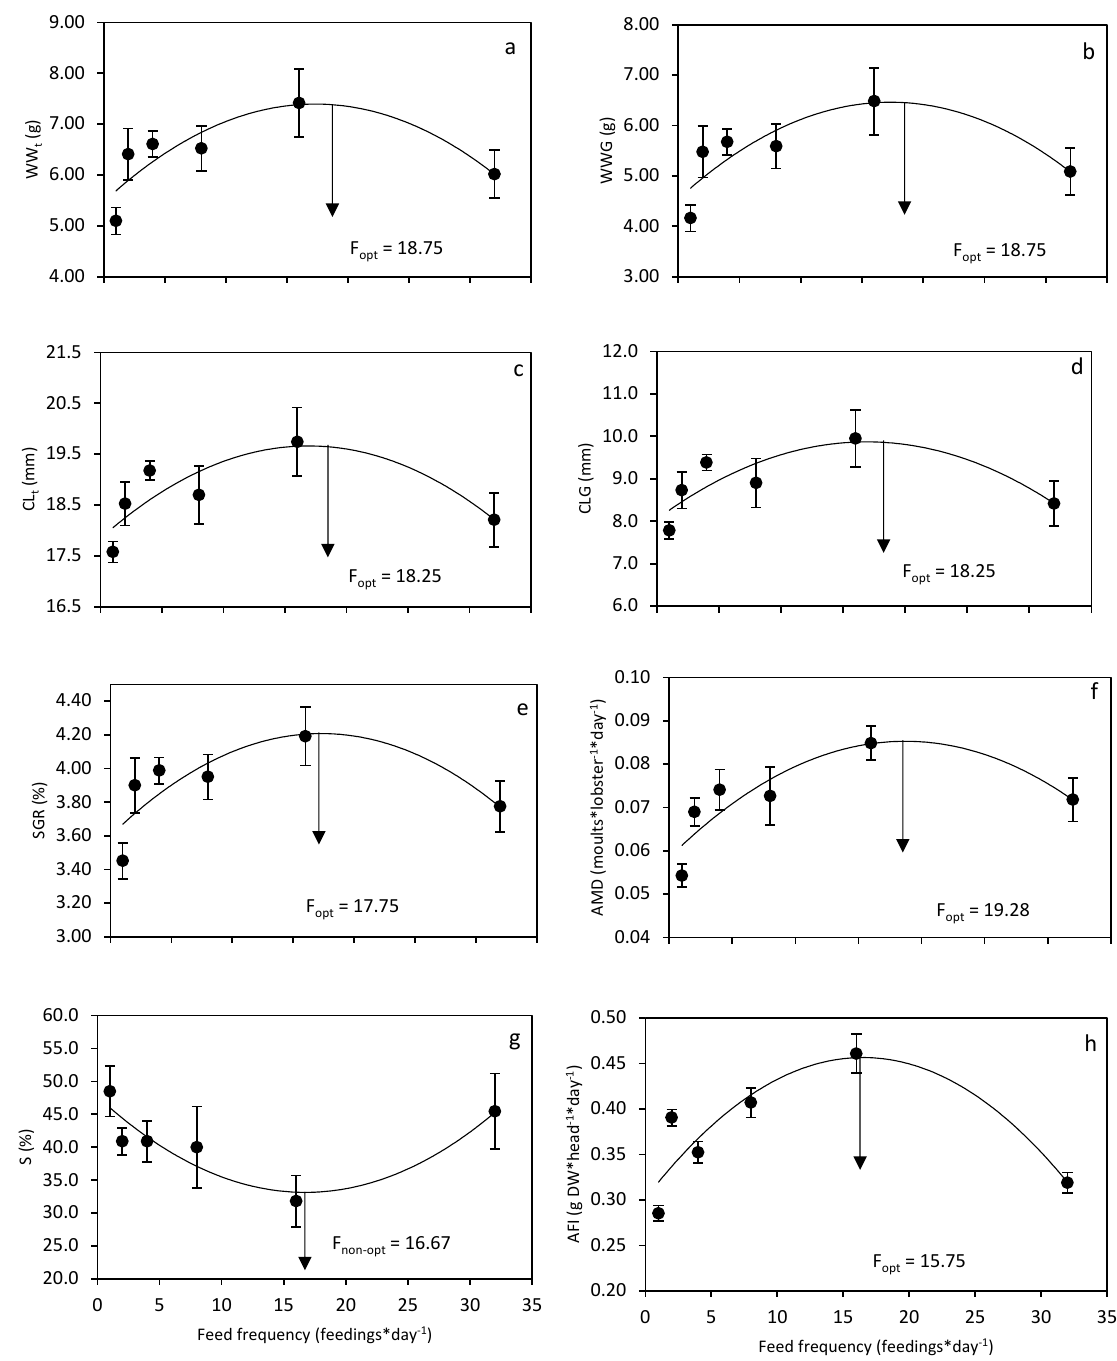
Figure 3. Effect of feed frequency on Panulirus ornatus ( a ) final wet weight (WWt), ( b ) wet weight gain (WWG), ( c ) final carapace length (CLt), ( d ) carapace length gain (CLG), ( e ) specific growth rate (SGR), ( f ) average moults per day (AMD), ( g ) survival (S) and ( h ) apparent feed intake (AFI). The graphs show mean values ± S.E. Arrows indicate optimal feed frequencies (Fopt) for WWt, WWG, CLt, CLG, SGR, AMD and AFI. For S, the arrow indicates the non-optimal feed frequency